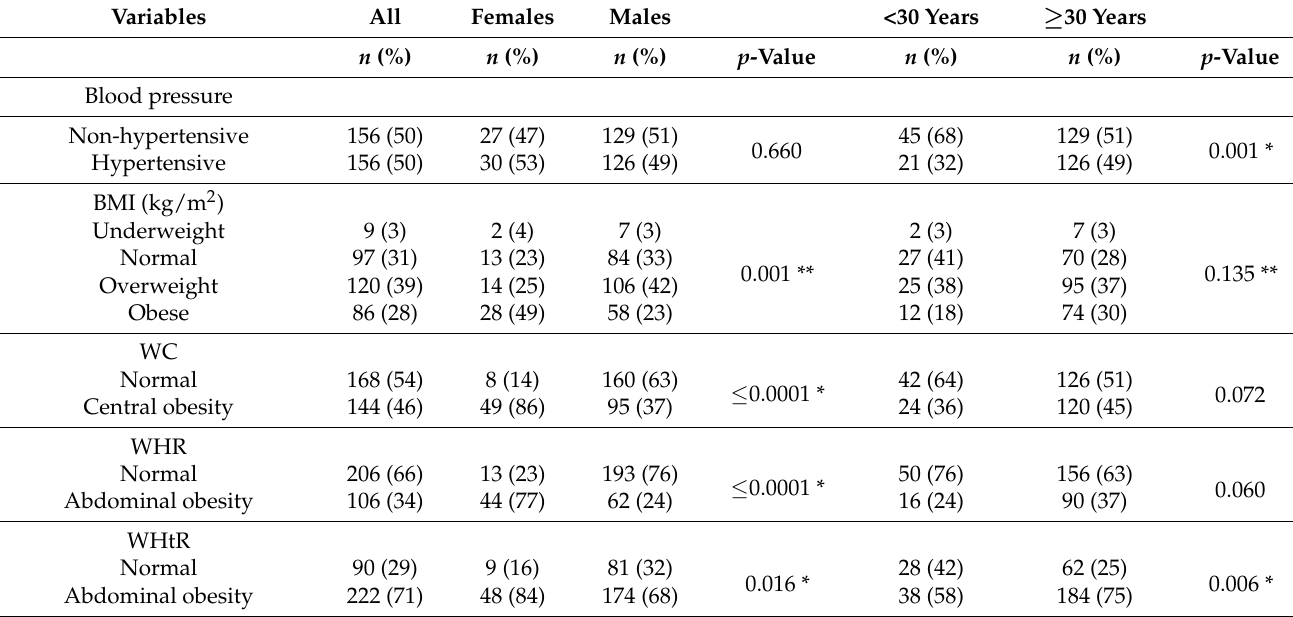
Table 2. Comparison of prevalence of hypertension and selected variables by gender and